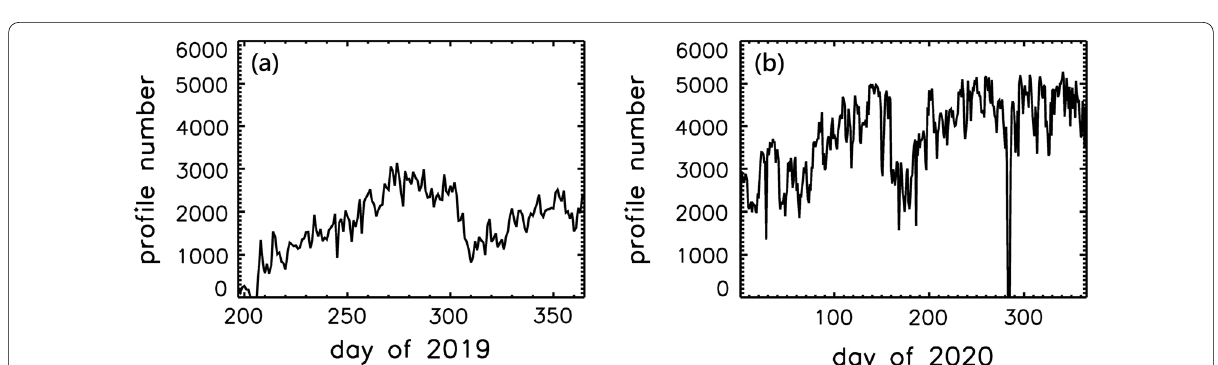
Fig. 4 Number of electron density profiles from 2019 to 2020. a Number of electron density profiles from 2019.197 to 2019.365; b the number of electron density profiles from 2020.001 to